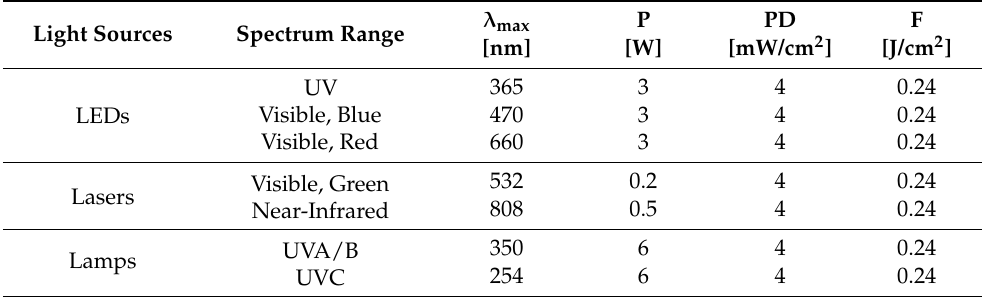
Table 1. Sources of ER and their physical